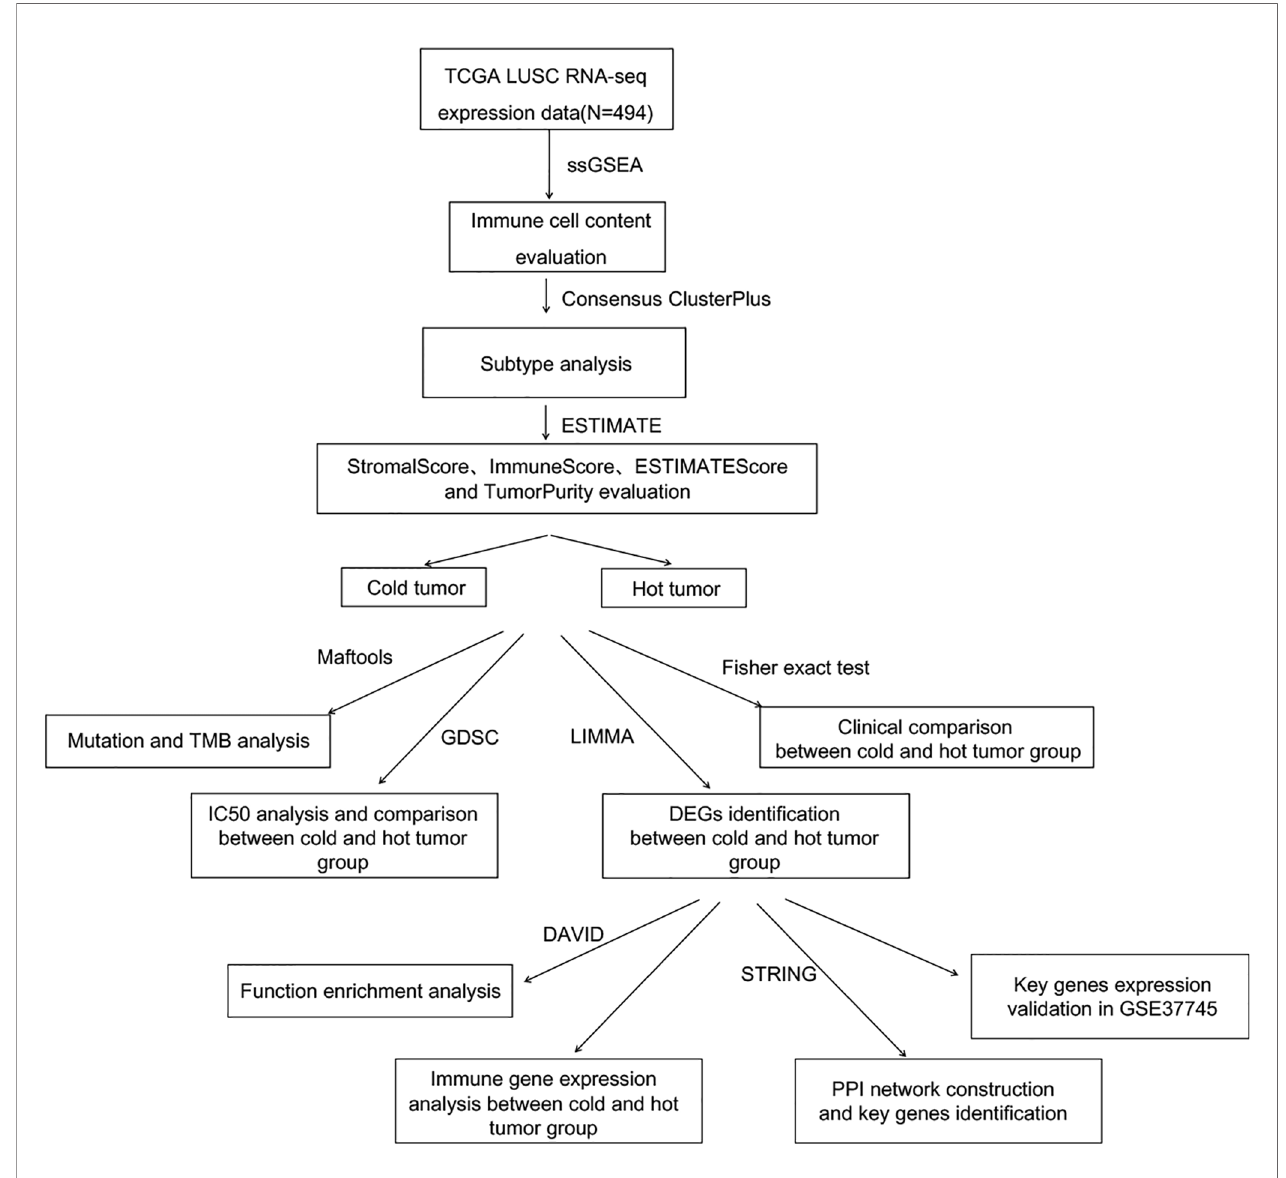
FIGURE 1 | Analysis fl